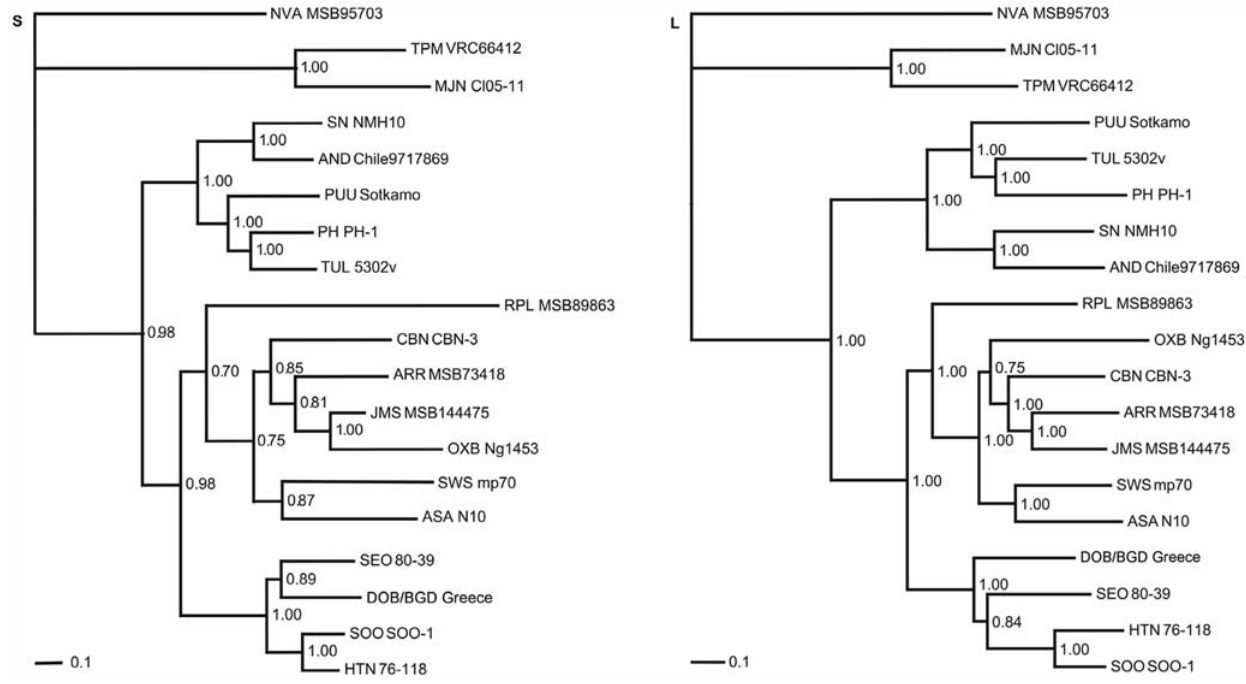
Figure 4. Phylogenetic trees generated by the maximum-likelihood (ML) method, using the GTR + I + C model of evolution as estimated, based on the coding regions of the full-length (S) 1,287-nucleotide S- and (L) 6,474-nucleotide L-genomic segments of NVAV. The phylogenetic position of NVA MSB95703 is shown in relationship to representative murine rodent-borne hantaviruses, including HTN 76– 118 (NC_005218, NC_005222), SOO SOO-1 (AY675349, DQ056292), DOB/BGD Greece (NC_005233, NC_005235) and SEO 80–39 (NC_005236, NC_005238); arvicoline rodent-borne hantaviruses, including TUL 5302v (NC_005227, NC_005226), PUU Sotkamo (NC_005224, NC_005225) and PH PH-1 (Z49098, EF646763); a neotomine rodent-borne hantavirus, SN NMH10 (NC_005216, NC_005217); and a sigmodontine rodent-borne hantavirus, AND Chile9717869 (NC_003466, NC_003468). Also shown are TPM VRC66412 (AY526097, EU001330) from the Asian house shrew ( Suncus murinus ); MJN Cl05–11 (EF641804, EF641806) from the Ussuri white-toothed shrew ( Crocidura lasiura ); CBN CBN-3 (EF543524, EF543525) from the Chinese mole shrew ( Anourosorex squamipes ); ARR MSB73418 (EF650086, EF619961) from the masked shrew ( Sorex cinereus ); JMS MSB144475 (FJ593499, FJ593501) from the dusky shrew ( Sorex monticolus ); SWS mp70 (EF636024, EF636026) from the Eurasian common shrew ( Sorex araneus ); RPL MSB89863 (FJ790772, EF540771) from the northern short-tailed shrew ( Blarina brevicauda ); ASA N10 (EU929072, EU929078) from the Japanese shrew mole ( Urotrichus talpoides ); and OXB Ng1453 (FJ539166, FJ593497) from the American shrew mole ( Neurotrichus gibbsii ). GenBank accession numbers are FJ539168 and FJ593498 for the NVA full-length S and L segments, respectively. The numbers at each node are posterior node probabilities based on 30,000 trees: two replicate Markov Chain Monte Carlo runs consisting of four chains of two million generations each sampled every 100 generations with a burn-in of 5,000 (25%). The scale bar indicates nucleotide substitutions per site.